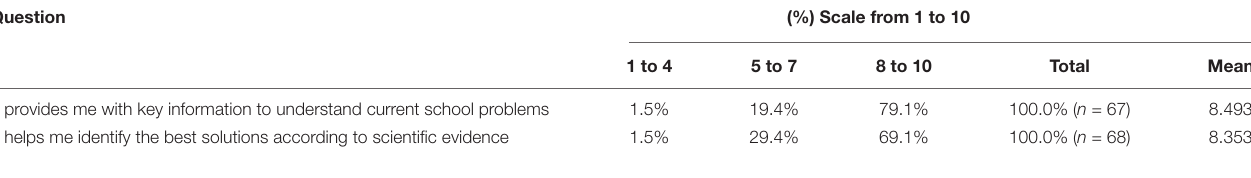
TABLE 4 | Impact of the seminar on the use of scientific knowledge for debating with other professionals.